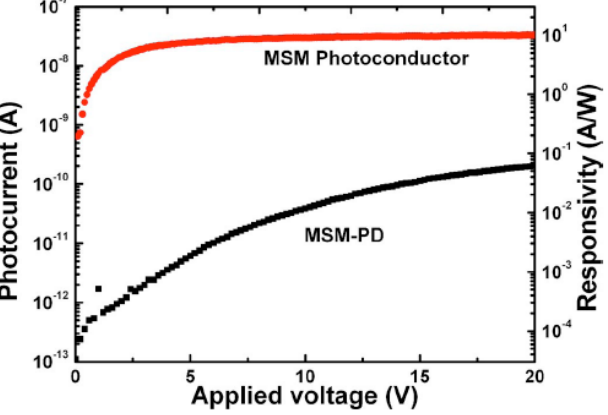
Figure 11. I-V characteristics of the photoconductor in comparison with a typical MSM photodetector during 220 nm light illumination (reprinted from Reference [91]).